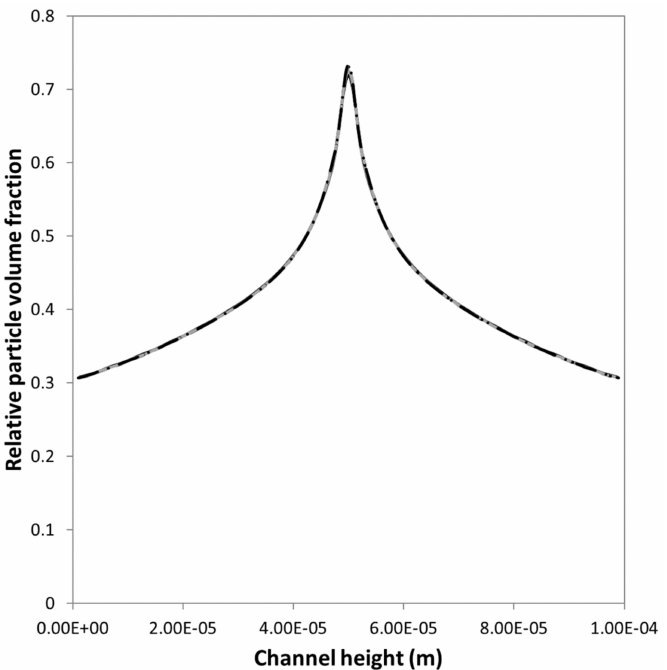
Figure A2. Grid refinement study for case 2. The relative particle volume fraction versus the channel height, measured 2.5 cm from the channel entrance. The grid cell number of the channel height is changed: 37 grid cells (black solid line); 41 grid cells (grey solid line); 45 grid cells (black dashed line); 47 grid cells (grey dashed line) and 49 grid cells (black dashed-dotted line).